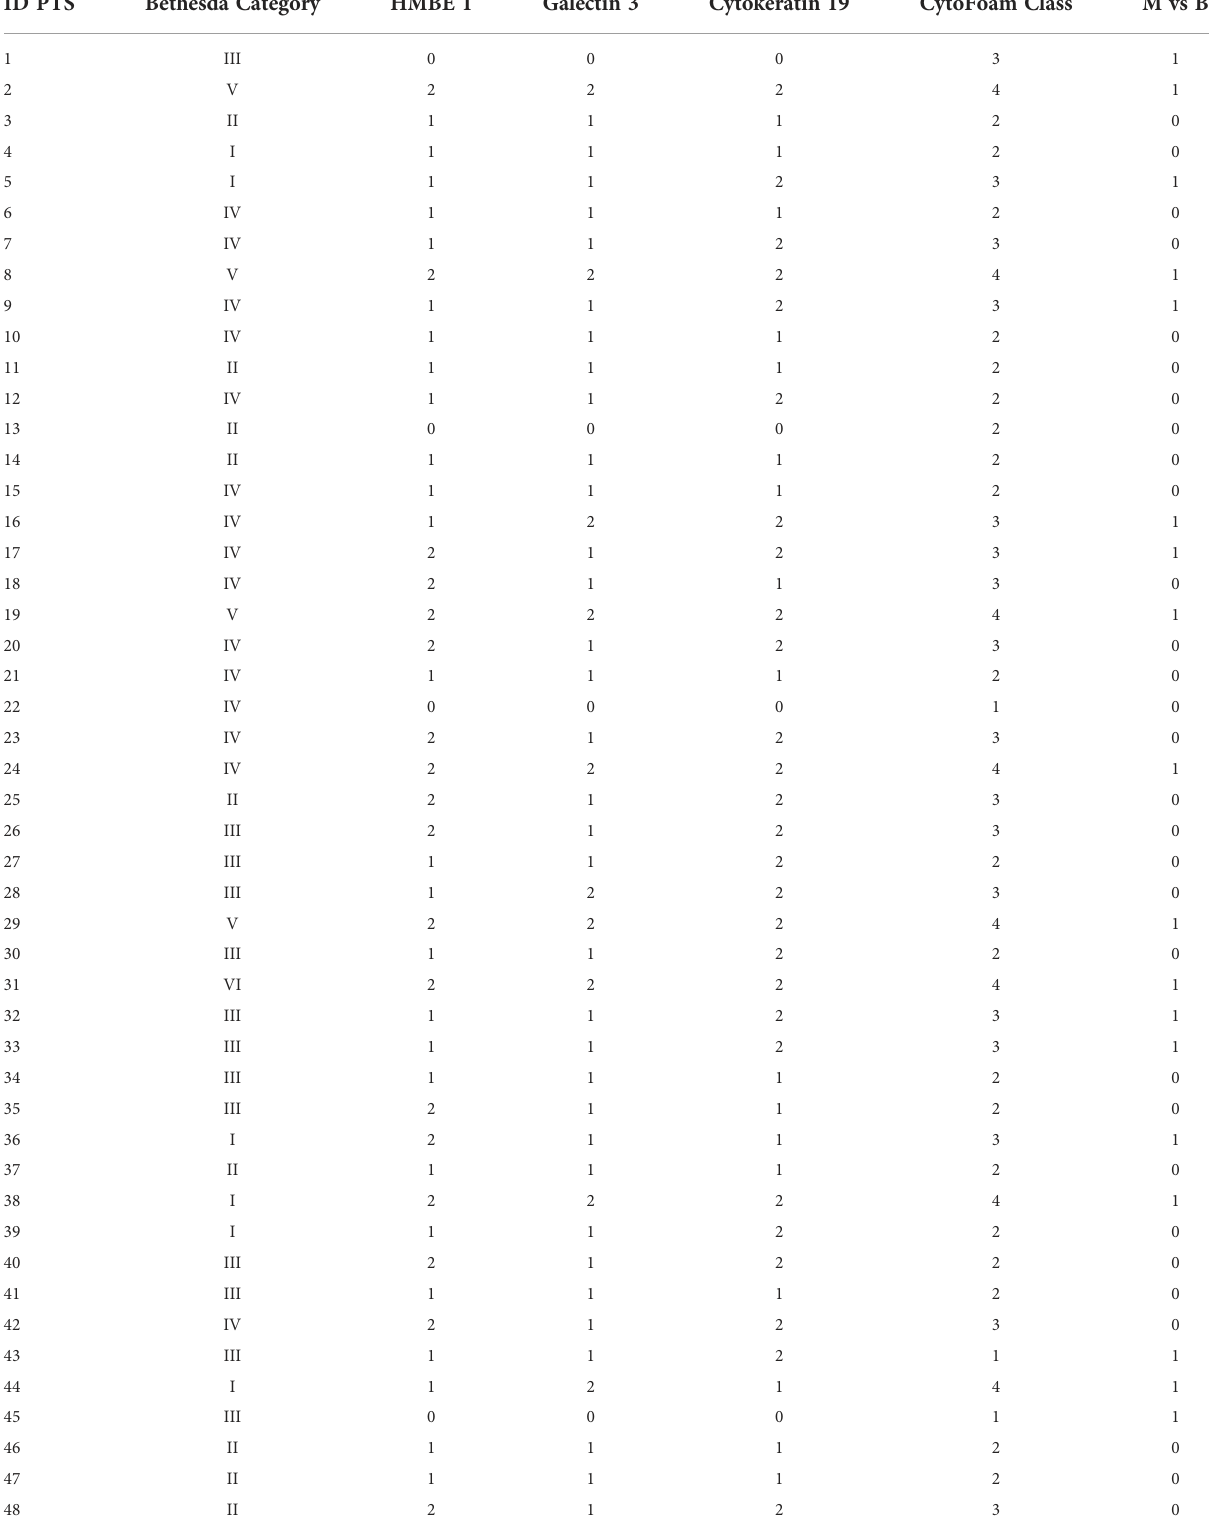
TABLE 6 Results of the Bethesda III patients ’ re-assessment. Cytological diagnosis vs. immunocytochemical